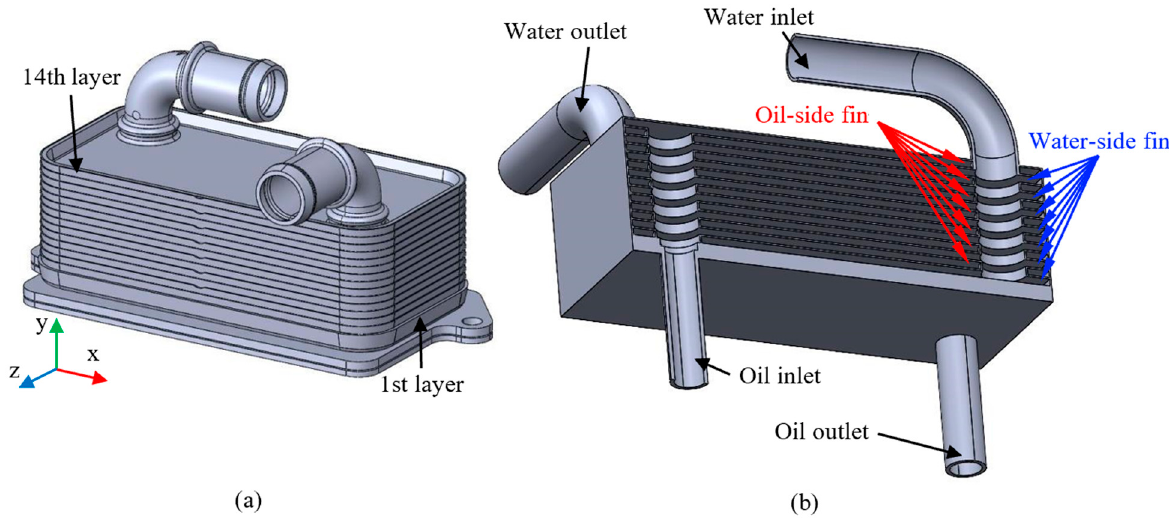
Figure 1. The heat exchangers are modeled from bottom to top as layers 1 to 14, where the odd- numbered layers are water-side fins and the even-numbered layers are oil-side fins: ( a ) Heat exchangers model, ( b ) Simplified model of heat exchangers.